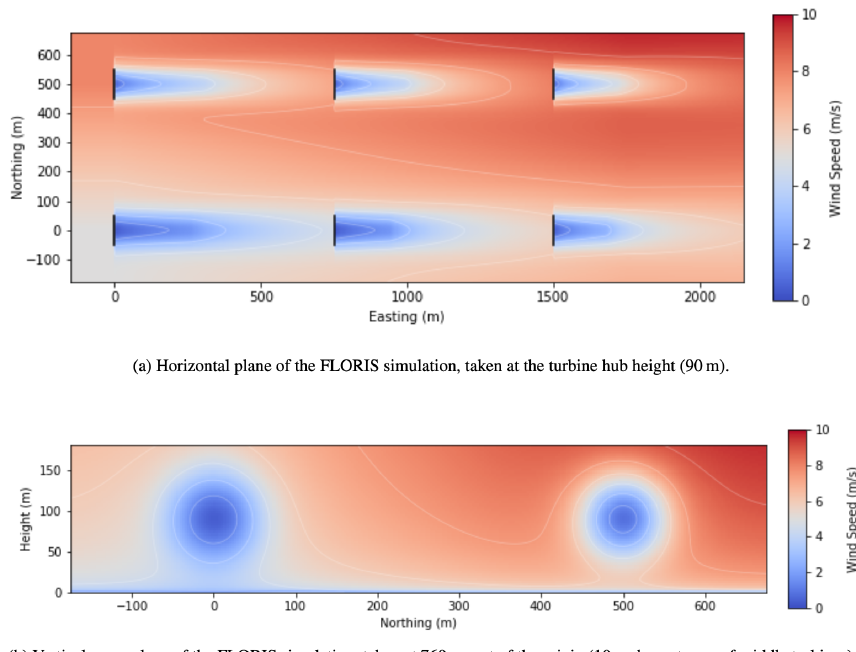
Figure 4. Visualizations of two planes showing the FLORIS flow field during a simulation with heterogeneous wind speed.